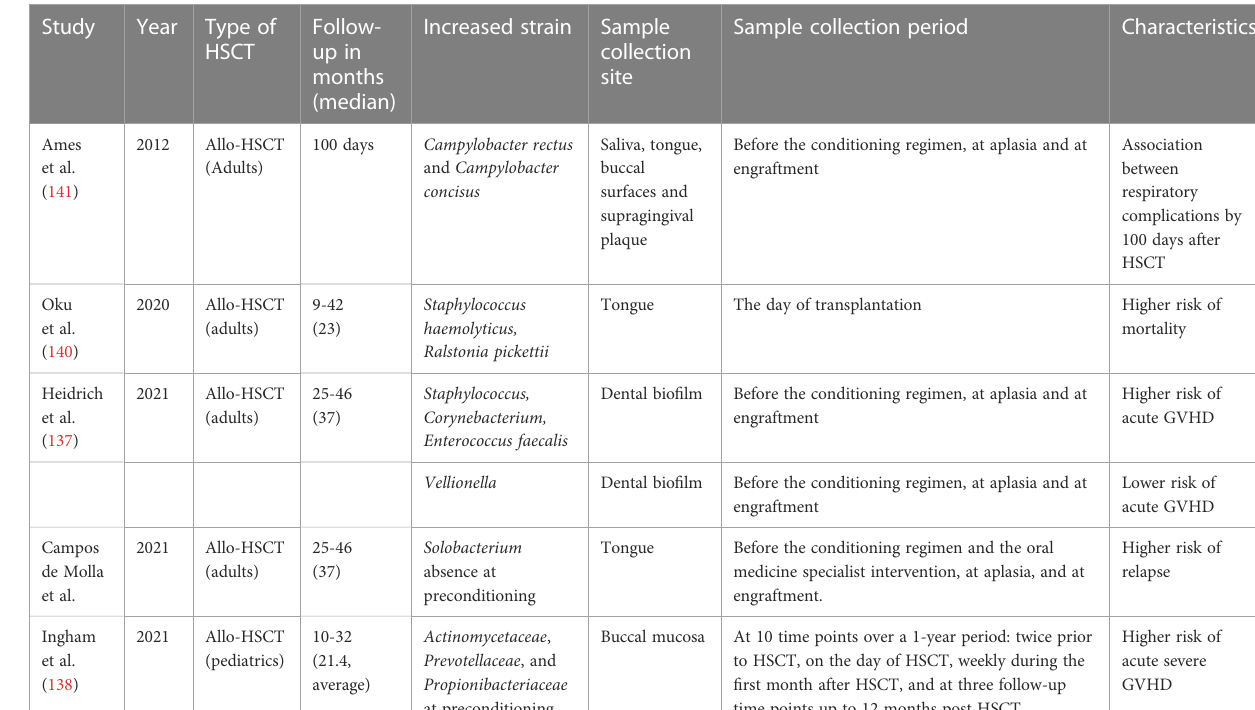
TABLE 1 Human oral microbiota and